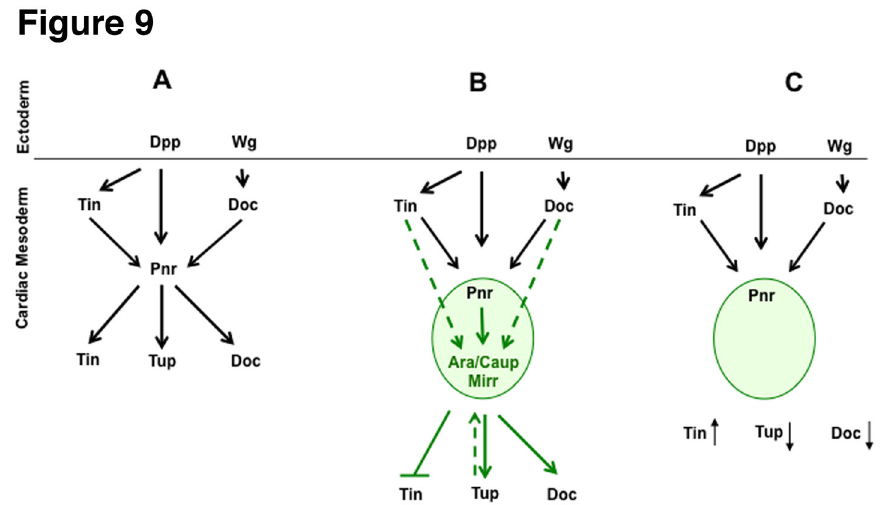
Figure 9. The cartoons depict regulatory interactions between the cardiac transcription factors including the members of the Iro-C based on our initial analyses on their function in the early dorsal mesoderm. For the sake of simplicity the cartoons neglect, for example, the different impacts of Ara/Caup and Mirr on the expression of the tested cardiac marker genes as well as additional regulatory interactions between the previously characterized factors. (A) In the previous model pnr was shown to be required for the maintenance of Doc, Tin and Tup in the cardiac mesoderm during stage 11. (B) Our data show that ara/caup and mirr act downstream of pnr or in combination with Pnr protein to regulate cardiac gene expression (specifically, to maintain Tup and Doc expression). Since Iro-C mutants were characterized by the presence of additional Tin-expressing cells, it appears that Iro-C is normally required to restrict the number of Tin-positive cells at stages 11/12. (C) In the absence of Iro-C Pnr is not sufficient to maintain Tup and Doc expression. The fact that we observe additional Tin-expressing cells could result from an earlier pnr - independent event in which Iro-C is involved. (A-C) Black arrows depict known interactions, green arrows depict our results, dashed arrows indicate the possibility that Tin, Doc and Tup could regulate Ara/Caup and Mirr directly without the involvement of Pnr.